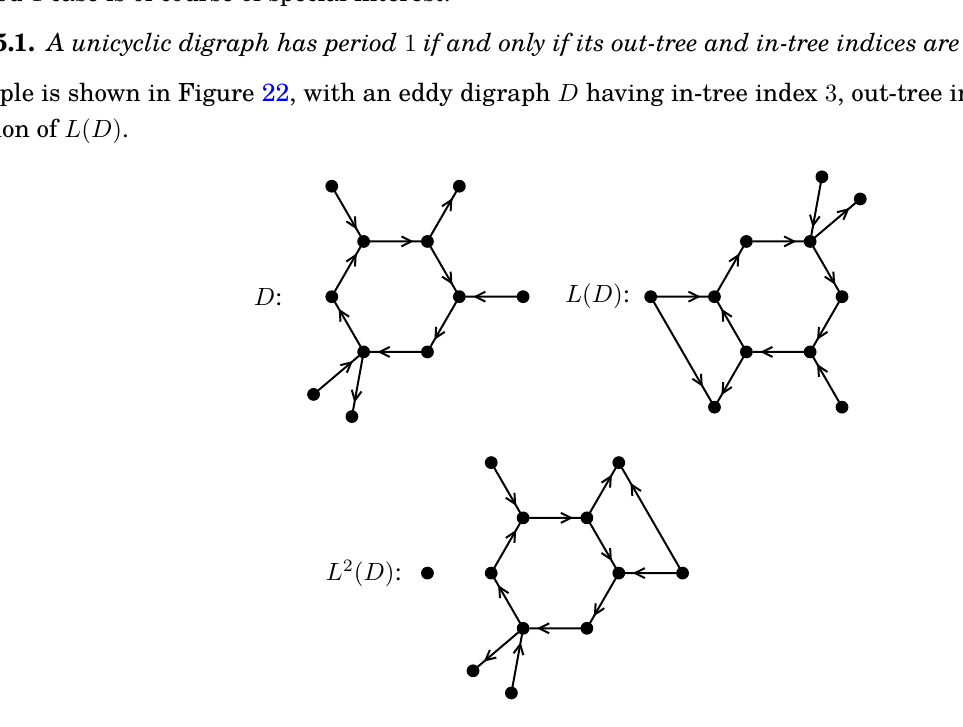
Figure 22: The line digraph of a digraph with a 6-cycle and relatively prime in-tree and out-tree